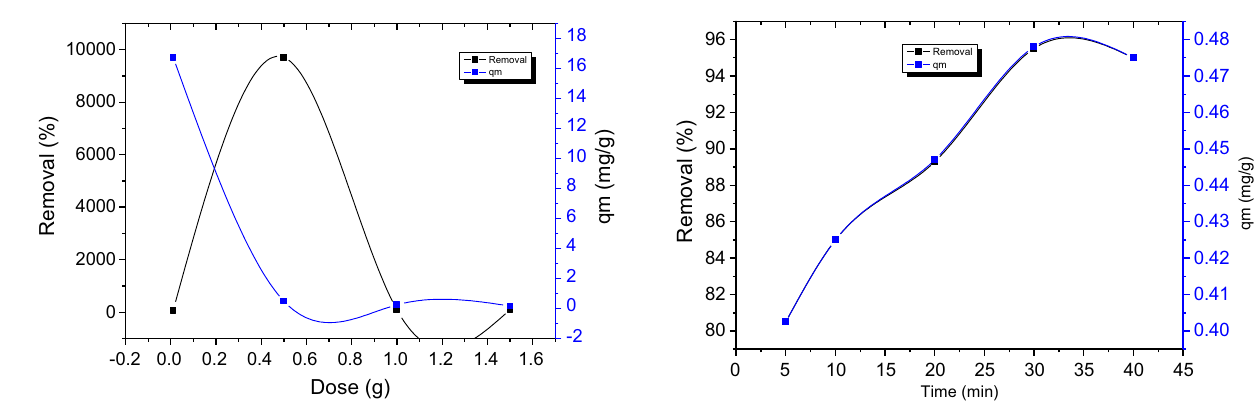
Fig. 8 Effect of contact time